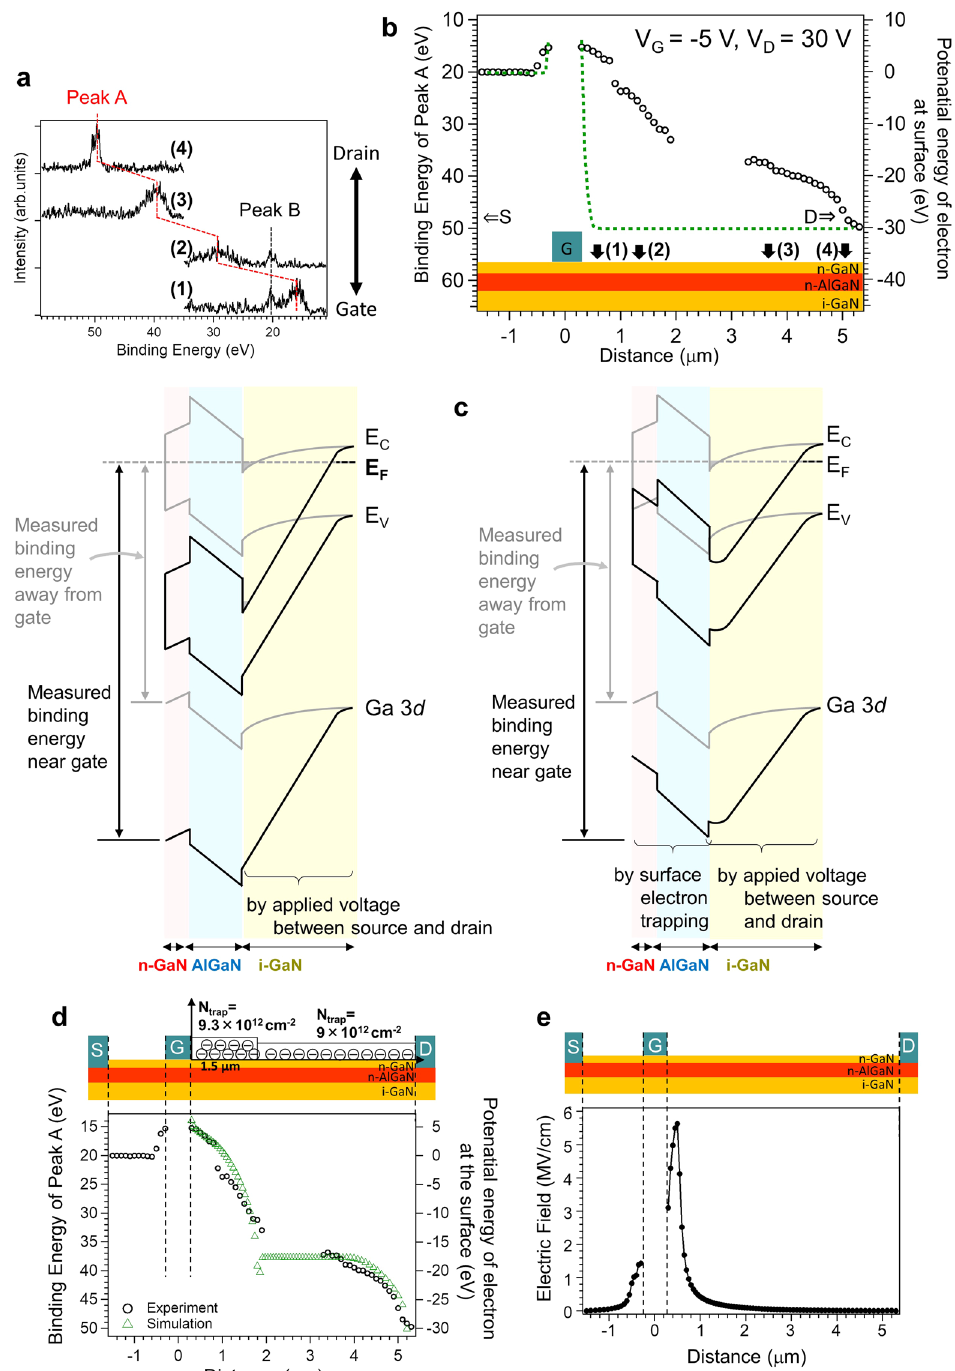
Figure 3. Operando photoelectron nanospectroscopy results of GaN-HEMT surface under application of both drain and gate biases. ( a ) Typical Ga 3 d spectra under application of drain (30 V) and gate ( − 5 V) biases. ( b ) Line profile of the binding energy of the main Ga–N peak under application of drain (30 V) and gate ( − 5 V) biases. (c ) Schematic band diagrams corresponding to (left) absence of surface electron trapping, and (right) occurrence of surface electron trapping. (d ) Simulations utilized to reproduce the experimental data by assuming surface electron densities. ( e ) Estimated local electric field distribution under application of gate ( − 5 V) and drain (30 V)